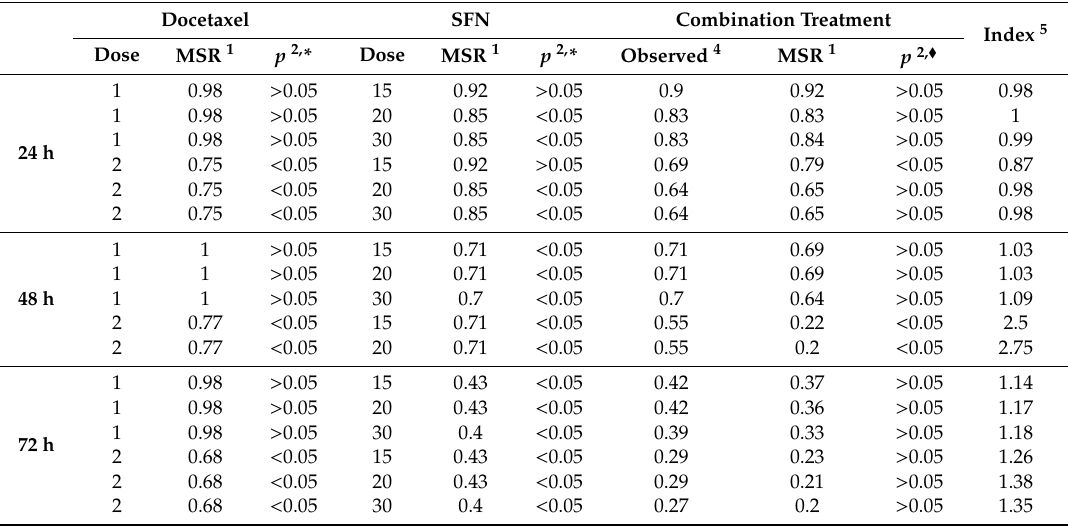
Table A4. Analysis of synergy between SFN and DOCE calculated by survival rate for DU 145 cells.